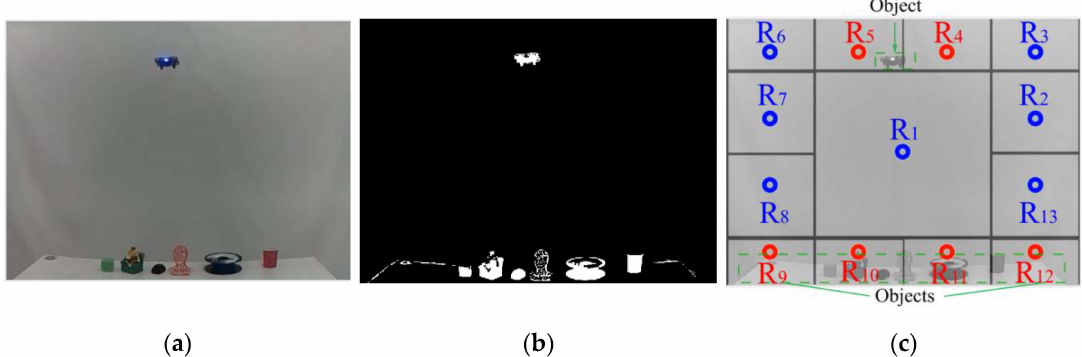
Figure 3. Test case: ( a ) RGB image obtained from vision sensor; ( b ) objects located using the binary image obtained from the environment; ( c ) free zones marked in blue, and zones with objects marked in